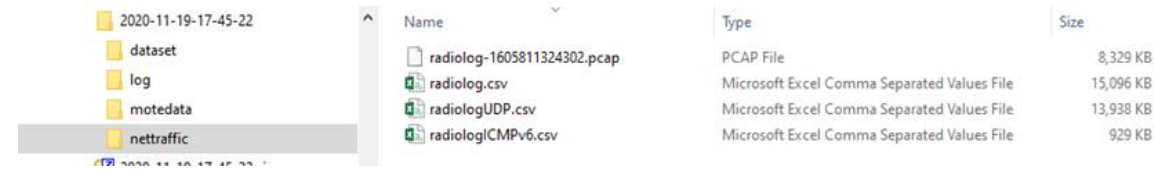
Figure 19. The “radiologICMPv6.csv” file and the “radiologUDP.csv” file in the “nettraffic” folder in the project environment.